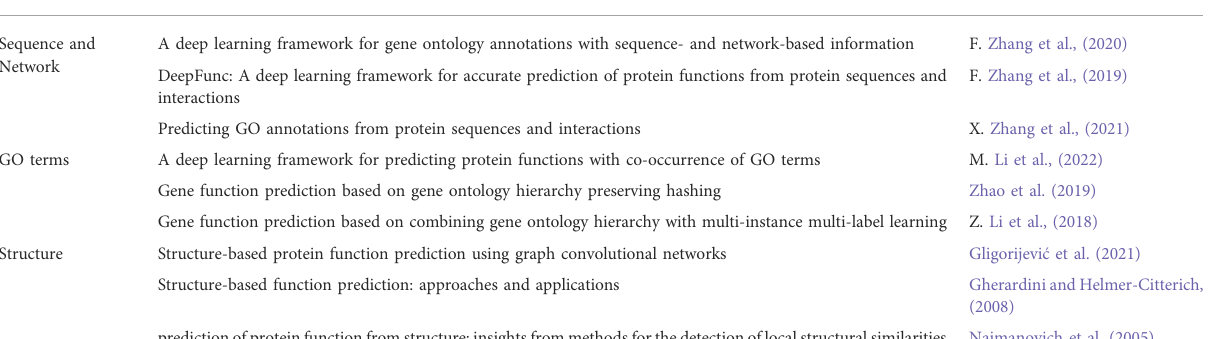
TABLE 1 Current computational methodologies of protein function